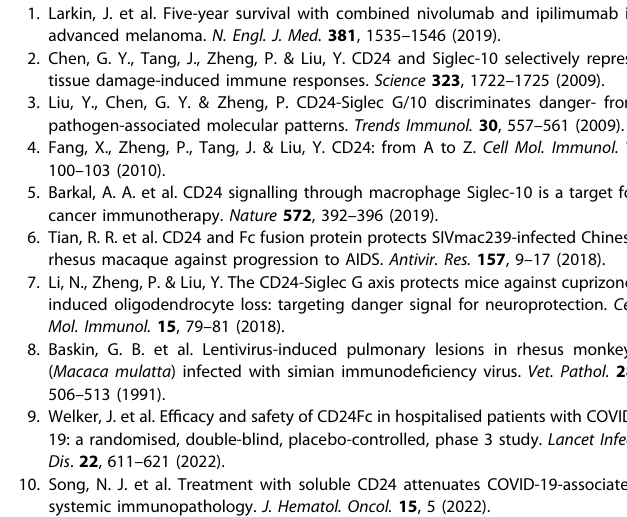
Fig. 1 CD24Fc ameliorates irAEs while preserving anti-tumor therapeutic effect. a – f Ctla4 h/h KI mice were i.p. treated with 100 – 150 μ g ipilimumab plus 100 μ g anti-PD-1 Ab (RMP1-14) together with 100 μ g CD24Fc or hIgFc on days 10, 13, 16, and 19. The CBC analysis was performed on day 41 after birth and necropsy was performed on day 42 after birth. a Timeline of drug treatment and analysis. b Body weight ( n = 6 – 9). c Pure red cell aplasia was evaluated by red blood cell (RBC) and blood hematocrit (HCT). d Representative images of H&E-stained paraf fi n sections from heart and lung. Scale bar, heart 200 μ m,lung 100 μ m. e Toxicity scores of heart, lung, liver and salivary gland based on in fl ammation ( n = 12 – 18). f Composite scores of all organs and glands. g – i Humanized NSG mice from the same donor of hCD34 + cells were treated with 100 µg ipilimumab together with 300 µg CD24Fc or hIgFc every 3 days for total four injections. g Body weight gain curve. One mouse from ipilimumab plus hIgFc treated group was excluded from analysis due to death on day 18. h Survival curve ( n = 13 – 15). i Representative images of H&E-stained paraf fi n sections from liver, lung and salivary gland. Scale bar, 100 μ m. j , k 1 × 10 5 B16-F10 tumor cells were injected (s.c.) on Ctla4 h/h mice ( n = 12 – 13) and treated (i.p.) with 200 μ g Ipilimumab plus 200 μ g anti-PD-1 (RMP1-14) together with 200 μ g hIgFc or CD24Fc on days 8, 11, and 14. Tumor volume ( i ) and mice survival curve ( j ) is shown. Data in ( b , g ) were analyzed by two-way repeat measurement ANOVA with Bonferroni multiple comparison test. ICIs + hIgFc vs ICIs + CD24Fc were compared at indicated time points. Data